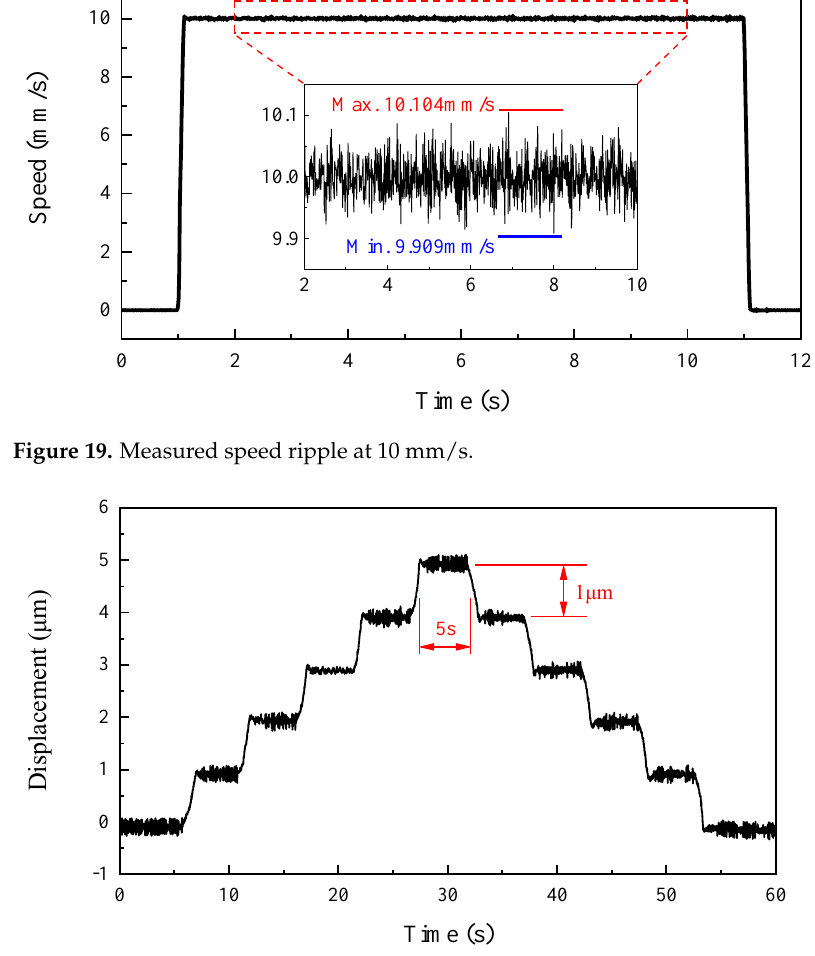
Figure 20. Resolution.